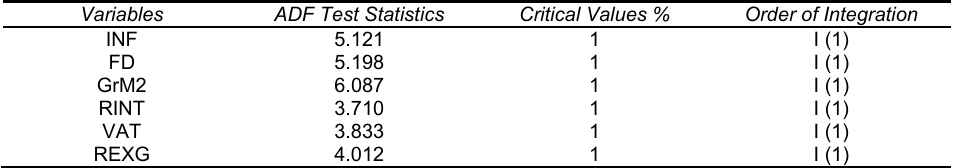
Table 1: Results of Augmented Dickey-Fuller (ADF) Stationarity Test Variables